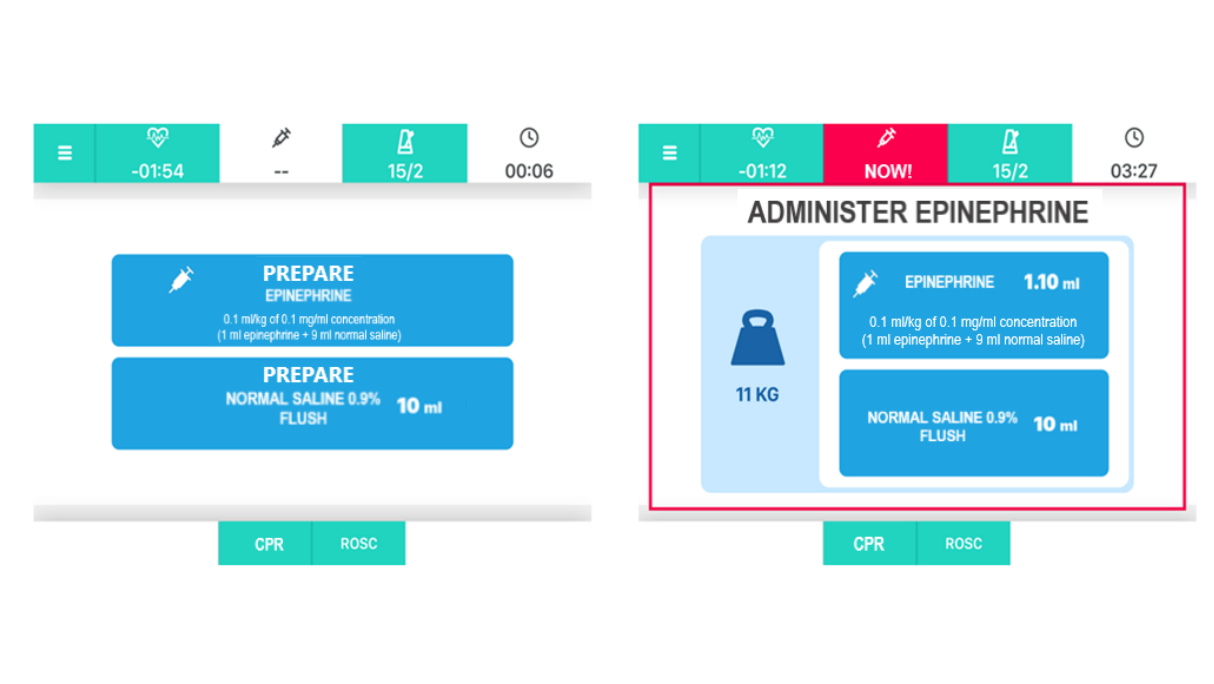
Figure 6. Epinephrine preparation and administration screens. CPR: cardiopulmonary resuscitation; ROSC: return of spontaneous